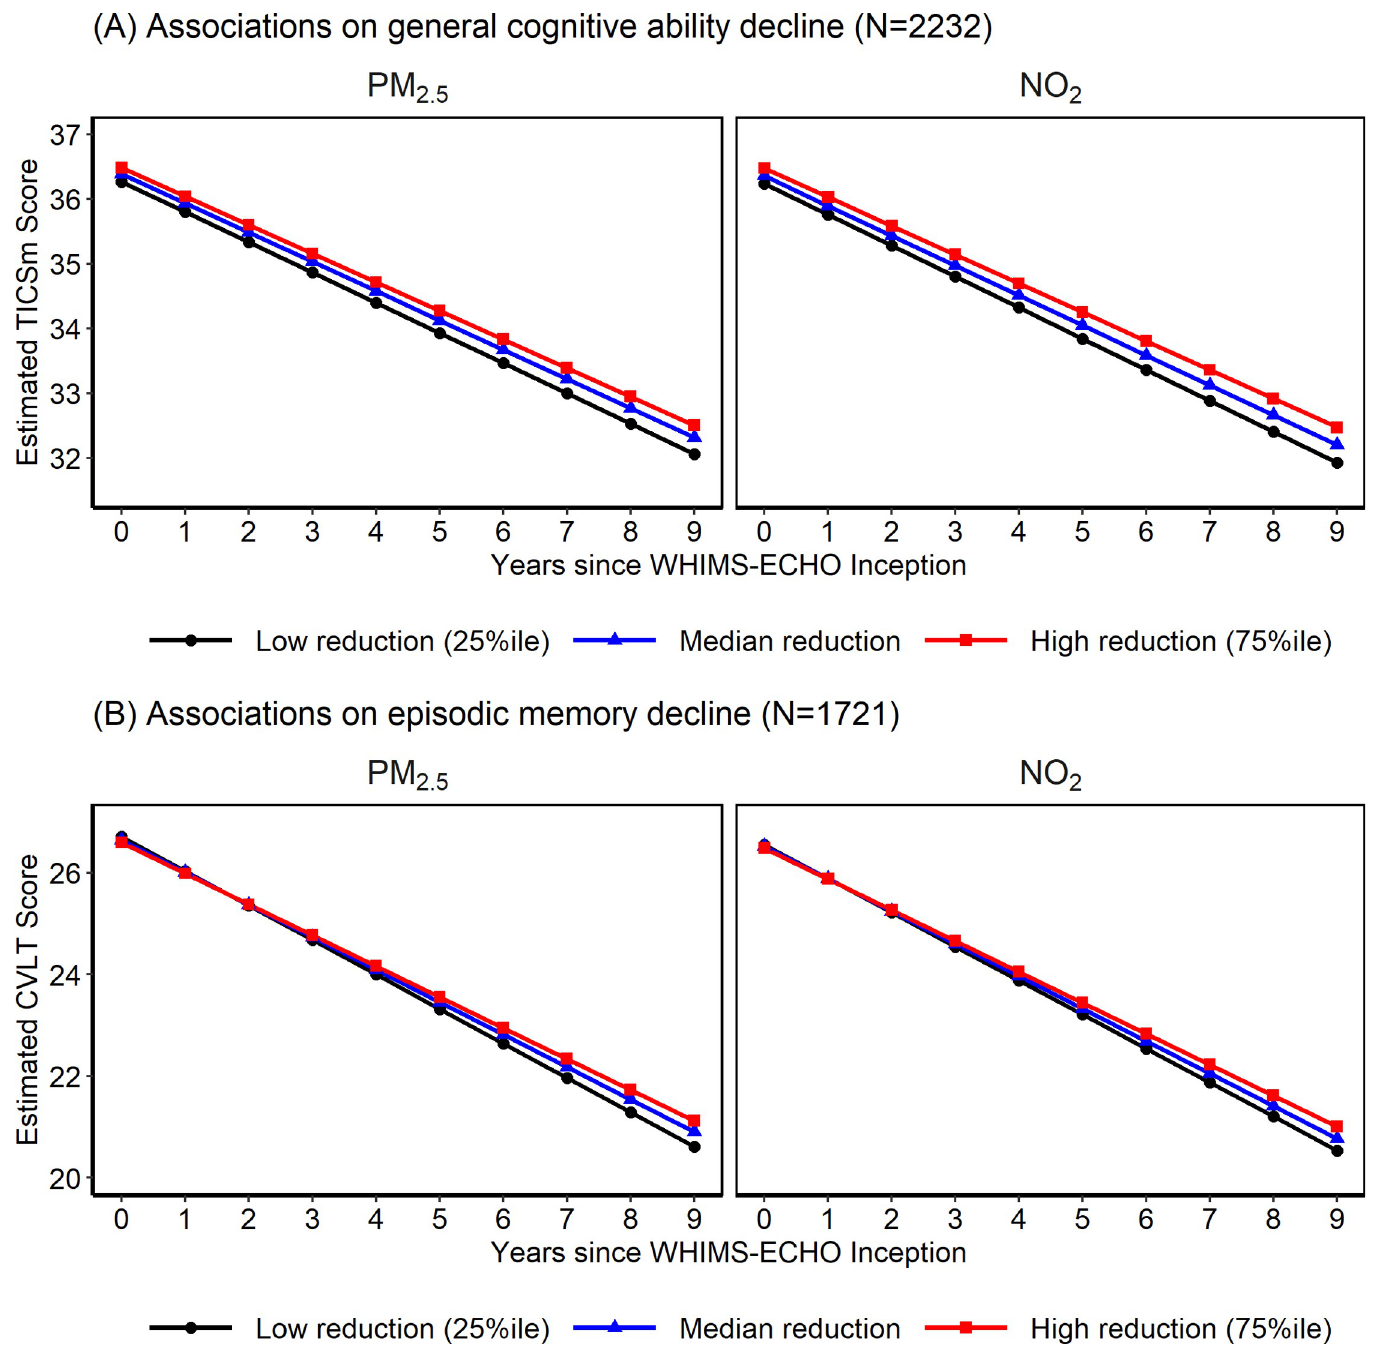
Fig 2. Estimated cognitive trajectory over time with different levels of AQ improvement in WHIMS-ECHO cohort. (A) Associations on general cognitive ability decline ( N = 2,232). (B) Associations on episodic memory decline ( N = 1,721). Estimated TICSm score (panel A) or CVLT score (panel B) change over time for low (25th percentile), median, and high (75th percentile) level of AQ improvement in PM 2.5 or NO 2 in the WHIMS-ECHO cohort. The estimated TICSm scores or CVLT scores were calculated using parameter estimates derived from Model III of Table 3, which were adjusted for spatial random effect, WHIMS-ECHO enrollment year, age, follow- up year, age interaction with follow-up year, time-varying propensity scores, demographic variables (geographic region and race/ethnicity), socioeconomic factors (education, income, and employment status) and neighborhood characteristics, lifestyle factors (smoking, drinking, and physical activities), prior hormone use, hormone therapy assignment, cardiovascular risk factors (hypertension, diabetes, and hypercholesterolemia), depression, BMI, and CVD histories. AQ, air quality; BMI, body mass index; CVD, cardiovascular disease; CVLT, California Verbal Learning Test; NO 2 , nitrogen dioxide; PM 2.5 , fine particulate matter; TICSm, modified Telephone Interview for Cognitive Status; WHIMS-ECHO, Women’s Health Initiative Memory Study-Epidemiology of Cognitive Health Outcomes.